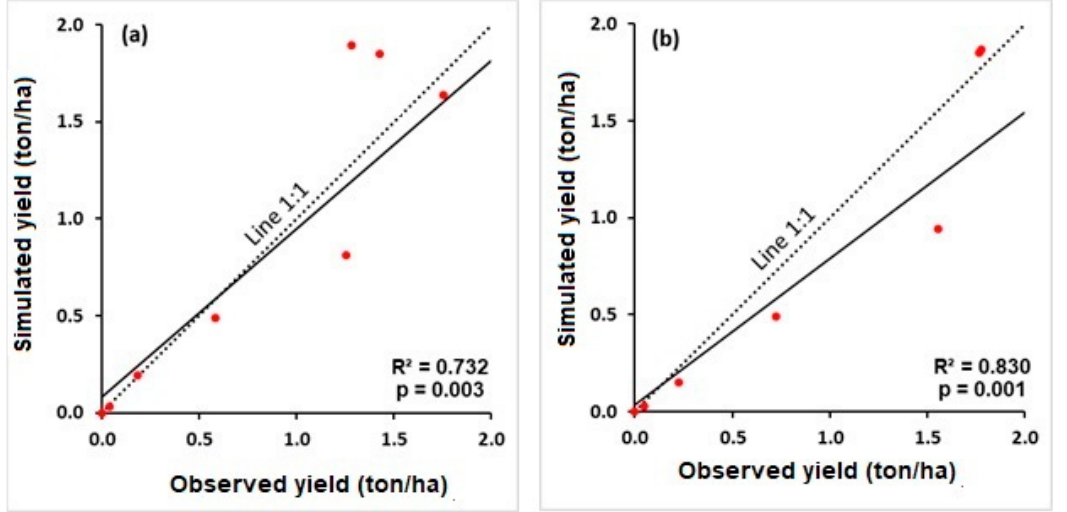
Figure 3. Simulated vs. observed yield for the Summer–Autumn season 2020 ( a ) and the Spring– Winter season 2021 ( b ).